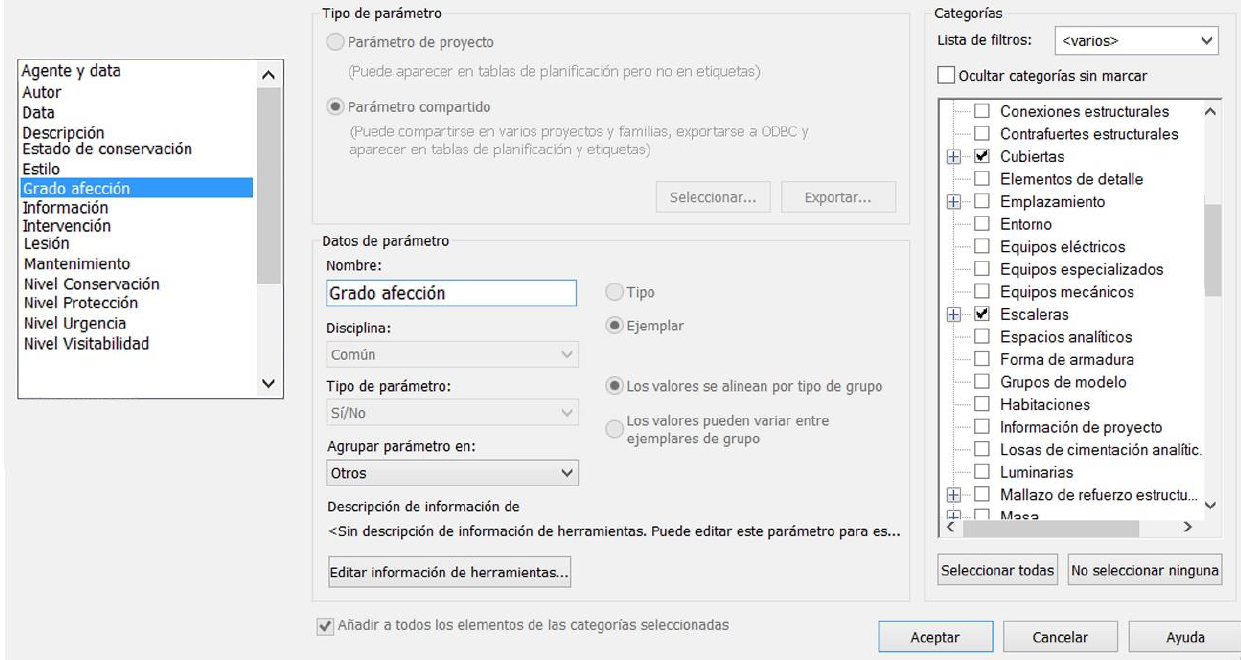
Figure 8. Heritage parameters, 2021.